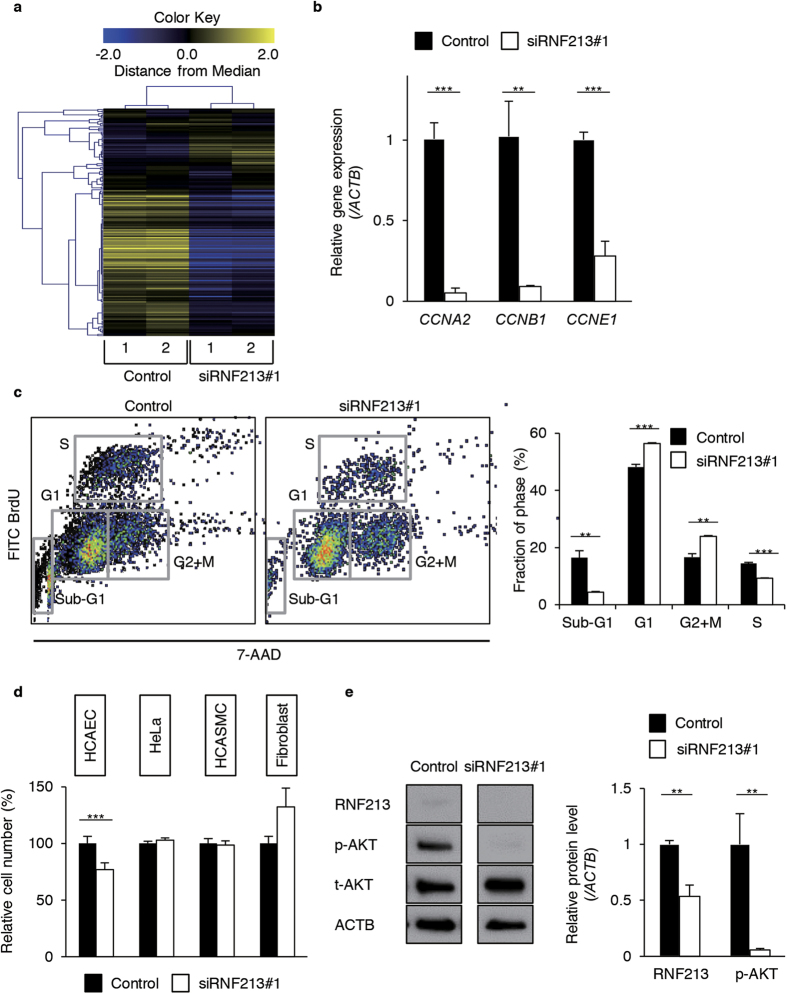
RNF213 up-regulates cell-cycle and proliferation of endothelial cells.(a) The heat map shows up (yellow) or down-regulated (blue) genes in siRNF213#1-treated or untreated HCAECs (n = 2 for each condition). Clustering of siRNA-treated cells and expression profiles for each experiment were conducted blindly. (b) Validating qPCR assays for CCNA2, CCNB1 and CCNE1 expressions in HUVECs with or without RNF213 knockdown (mean ± SD, n = 3, using Student’s t-test). **p < 0.01, ***p < 0.001. (c) Flow-cytometry analysis for cell cycles of HUVECs. Used siRNAs (siRNF213#1 or control) are denoted at the top. The left two panels show 2D-plots for fluorescence intensity of FITC-labeled BrdU and that of 7-AAD. Fractions (%) of cells in G0/G1, S, G2+M and sub G0/G1-phases are indicated with squares. Bar plots on the right shows significant decrease in S-phase with siRNA-mediated knockdown of RNF213 (n = 3, using Student’s t-test, ***p < 0.001). (d) MTS assay for HCAECs, HeLa, HCASMCs and fibroblasts in the presence of RNF213-specific siRNA (siRNF213#1) or control siRNA (n = 3 in each group, using Student’s t-test, ***P < 0.001). (e) Western blots for phosphorylated form of AKT (p-AKT), total AKT (t-AKT) and ACTB in HUVECs. Quantitative data from three independent Western blot analyses are shown as plots on the right (mean ± SD) and analyzed using Student’s t-test. **p < 0.01. Full length blots are presented in Supplementary Fig. S7.